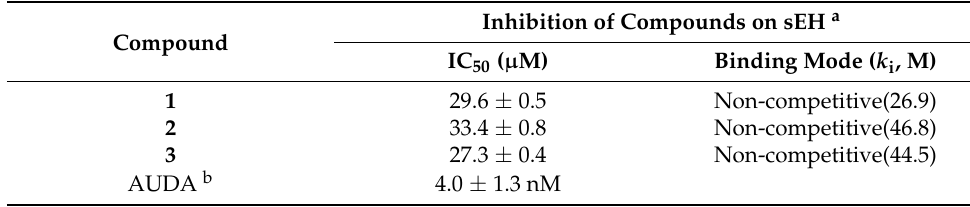
Table 1. sEH inhibitory effect of quaternary isoquinoline alkaloids 1 – 3